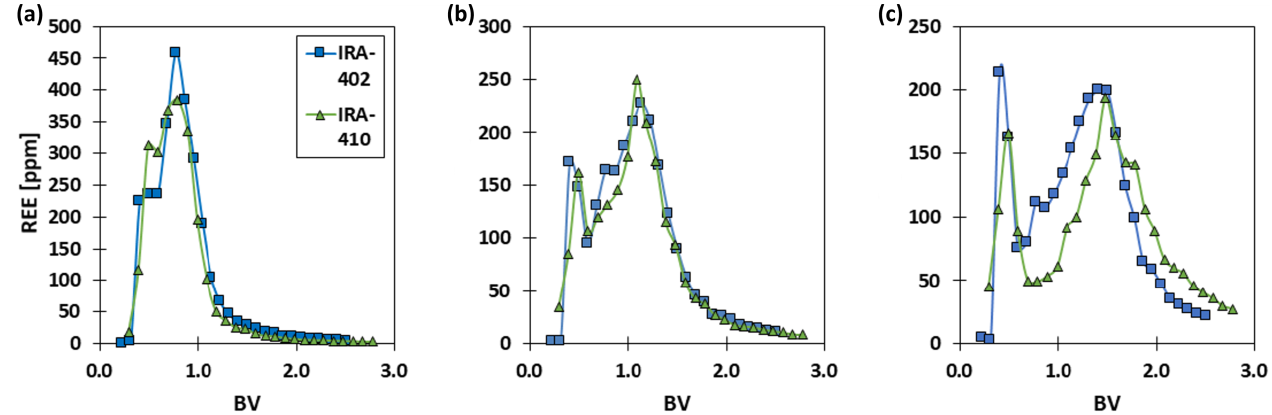
Figure 3. Elution profiles of ( a ) La; ( b ) Nd; and ( c ) Eu on IRA-402 and IRA-410. (T = 298 ± 2 K; flowrate = 2.98 BV/h; feed pulse = 0.025 BV, Eluent = 10 mM HNO 3 ; Feed solution = #2).